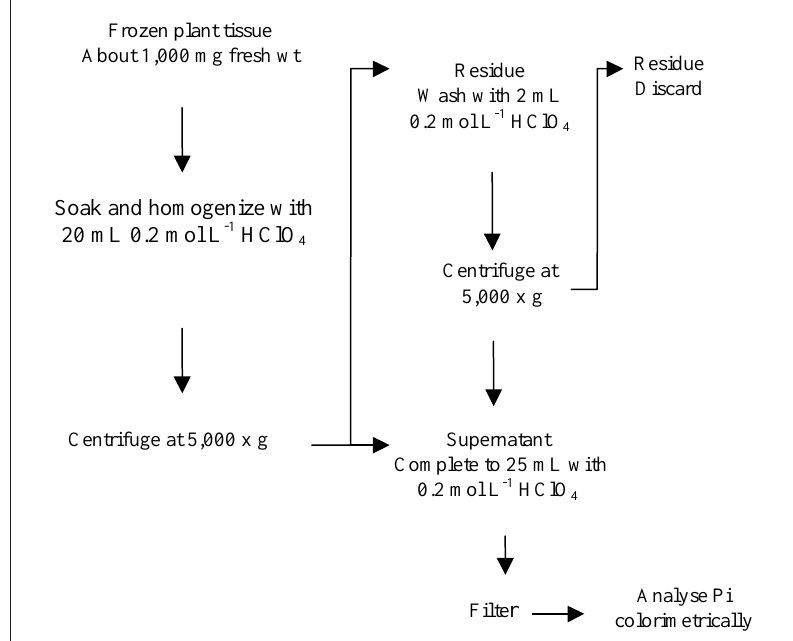
Figure 1. Inorganic P (Pi) fractionation scheme in soybean tissue. Based on Hogue et al. (1970)